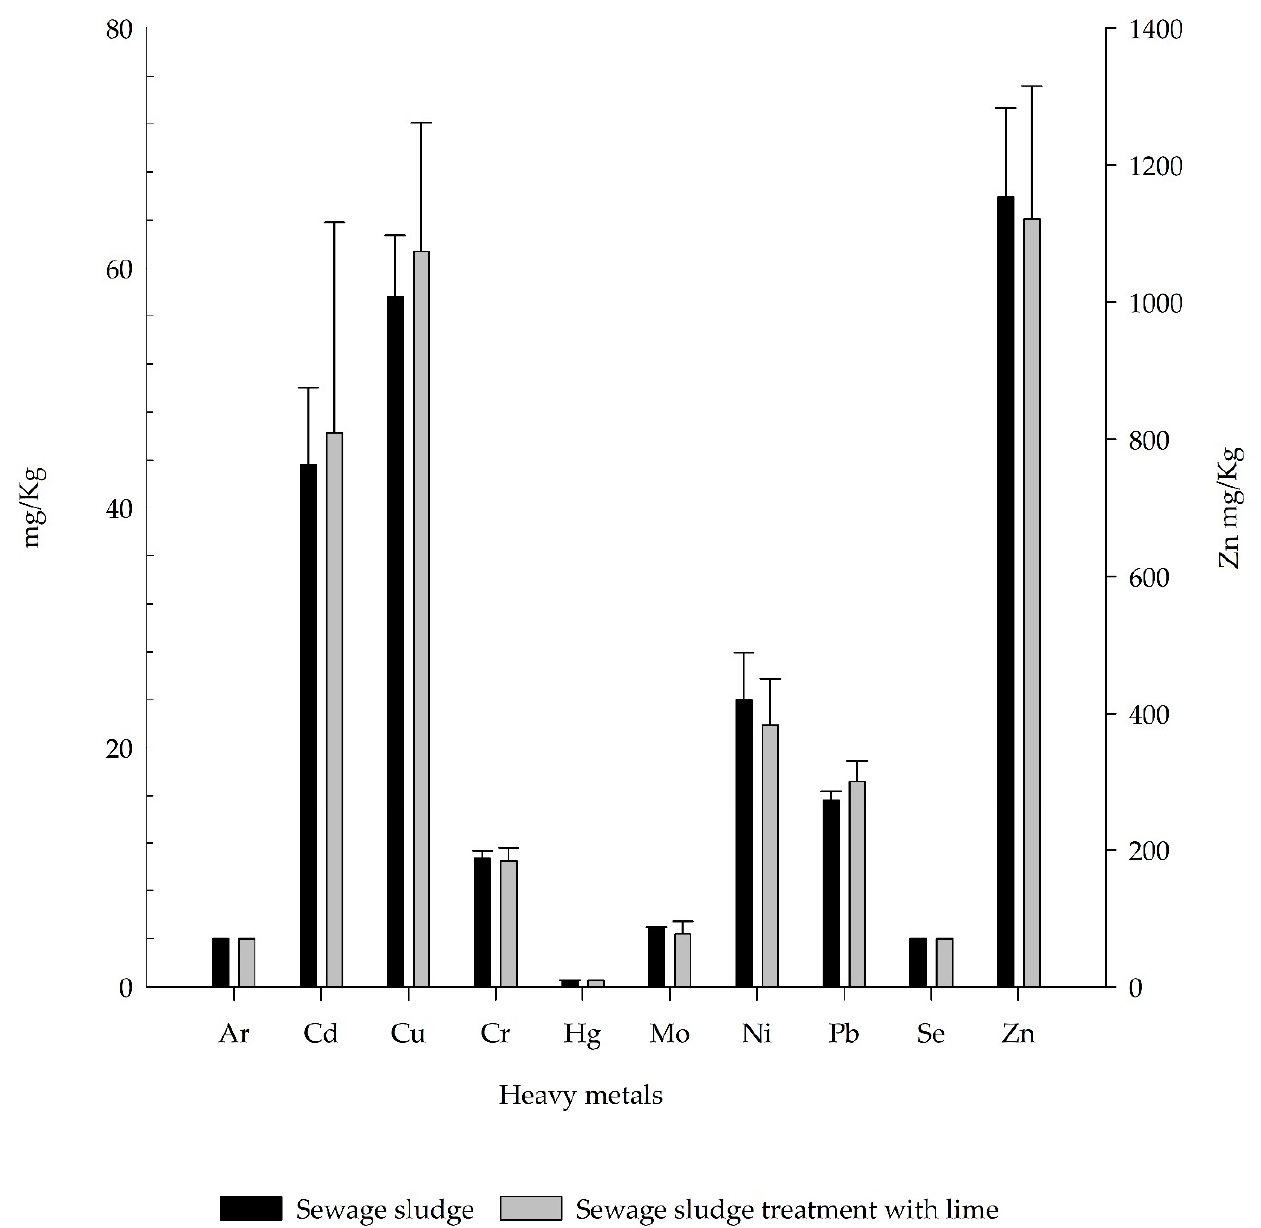
Figure 5. Chiquinquirá, Boyacá (Colombia) WWTP heavy metal concentration in treated and untreated